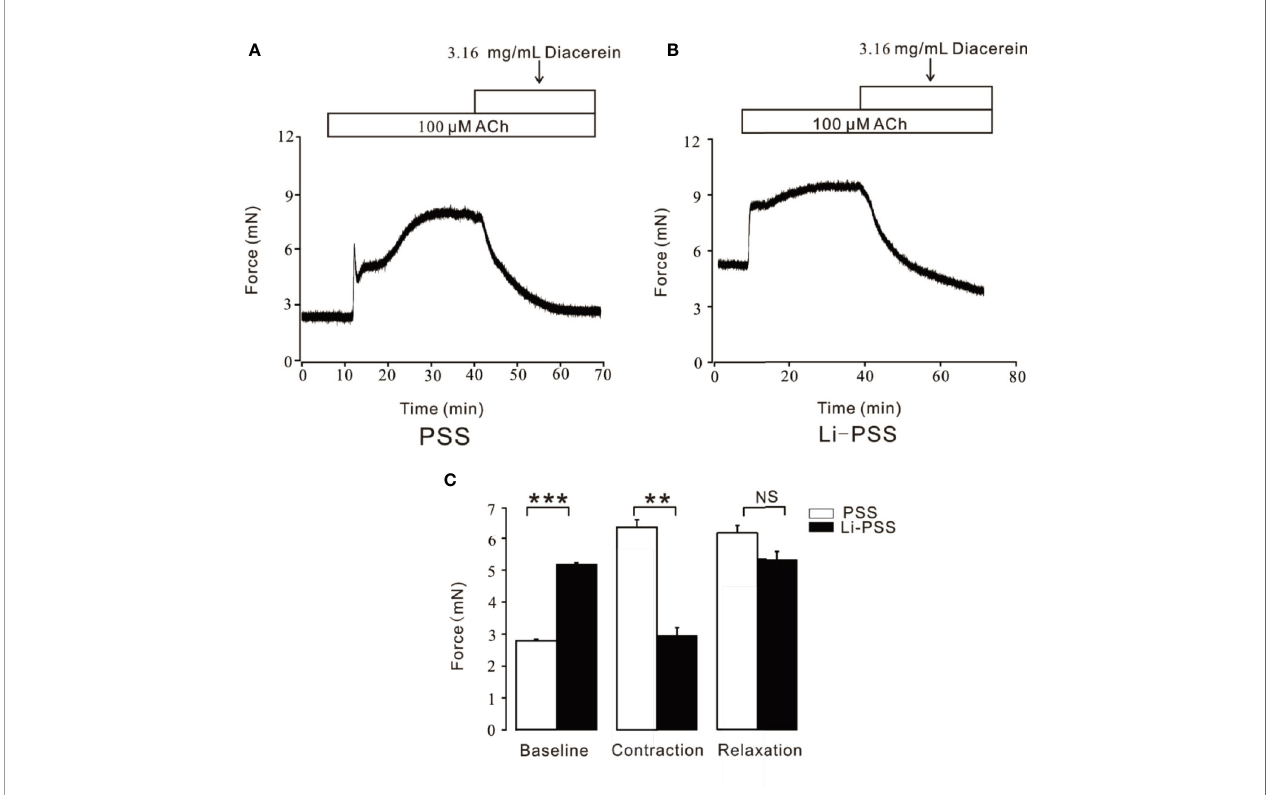
FIGURE 8 | Diacerein switched Na + /Ca 2+ exchangers (NCX). (A) 3.16 mg/ml diacerein attenuated 100 m M ACh-induced contraction under physiological salts solution (PSS) condition (n = 6/6 mice). (B) 3.16 mg/ml diacerein reversed ACh-induced contraction under Li-PSS condition. Statistically higher baseline, statistically smaller net contractile force, and non-signi fi cantly relaxant value were observed (n = 6/6 mice). (C) The bar graph showed the comparisons of net forces at the baseline, contraction, relaxation (n = 6/6 mice). NS, no signi fi cant; **, p < 0.01; ***, p <